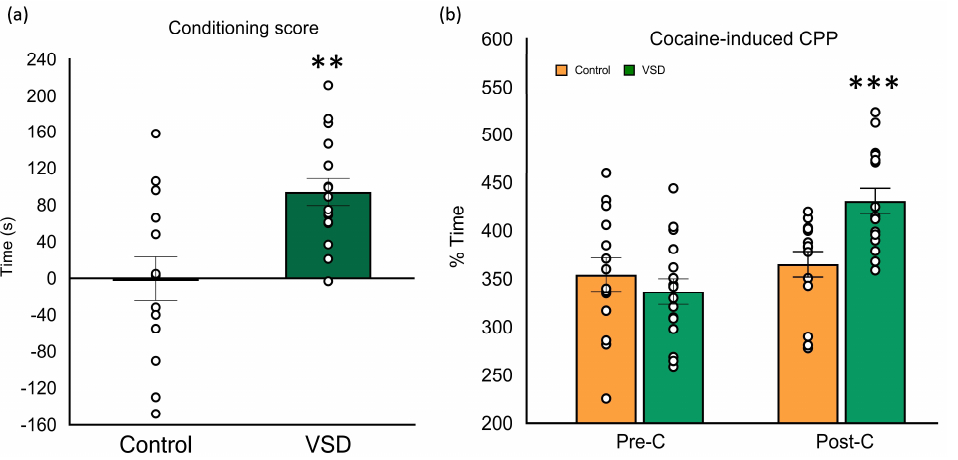
Figure 7. Vicarious Social Defeat (VSD) female mice showed preference in cocaine-induced Conditioned Place Preference (CPP). Female mice were divided into Control (n = 14) and VSD (n = 14). ( a ) The bars represent the conditioning score (difference in seconds between the time spent in the drug-paired compartment after the conditioning sessions and the time spent in the same compartment during Pre-C); or ( b ) the time (in seconds) spent in the drug-paired compartment before conditioning sessions in the pre-conditioning test (Pre-C) (light gray bars) and after conditioning sessions in the post-conditioning test (Post-C) (dark gray bars), during which CPP was induced with 1,5 mg/kg of cocaine. Stress effect in the conditioning score [F (1,26) = 12.004, p < 0.002], ** p < 0.01 significant difference with respect to the control group. Interaction Day x Stress in the time spent in the drug- paired compartment [F (1,26) = 10.395, p < 0.003], *** p < 0.001 significant difference in the time spent in the drug-paired compartment vs. Pre-C